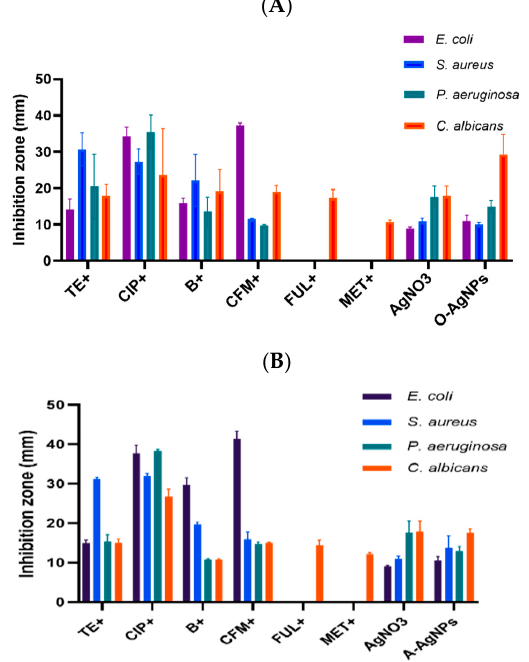
Figure 9. Synergistic effect of the antibiotics and AgNPs fabricated using O. forsskalii seeds ( A ) and synergistic effect of the antibiotics and AgNPs fabricated using A. arabica gum ( B ).